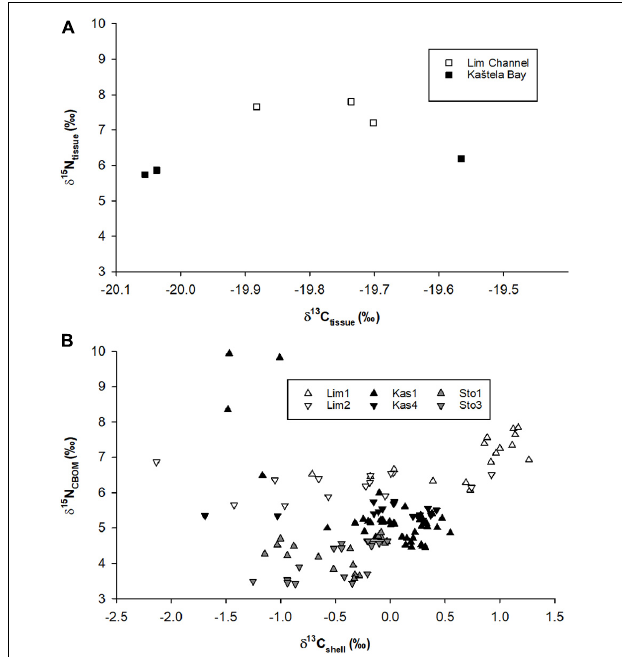
FIGURE 7 | Relationship between δ 13 C and δ 15 N in (A) muscle tissue and (B) shell of Pinna nobilis .